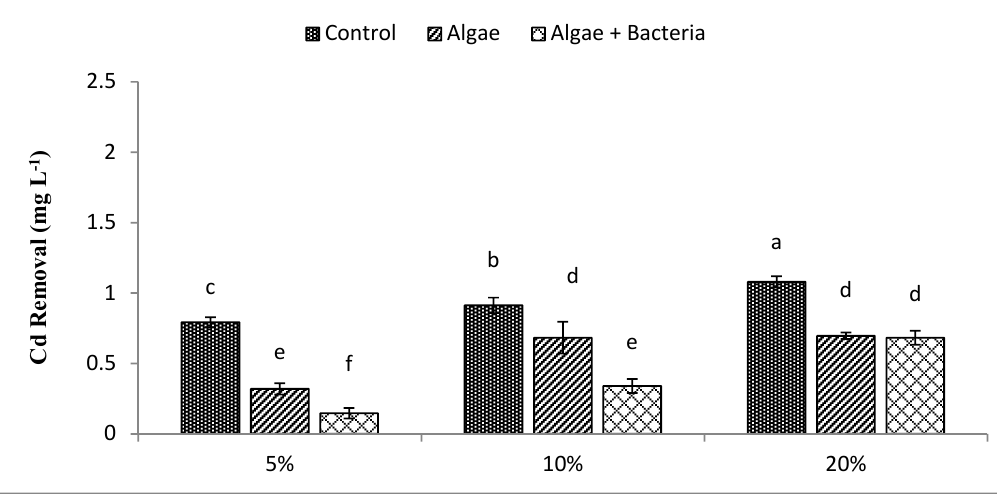
Figure 4. Efficiency of algae and algal–bacterial consortium for cadmium removal from textile industry wastewater at different dilution levels. Column shows mean values, and bars shows standard deviation (SD) of means. All means followed by different letters were significantly different according to Tukey HSD test at p < 0.05.